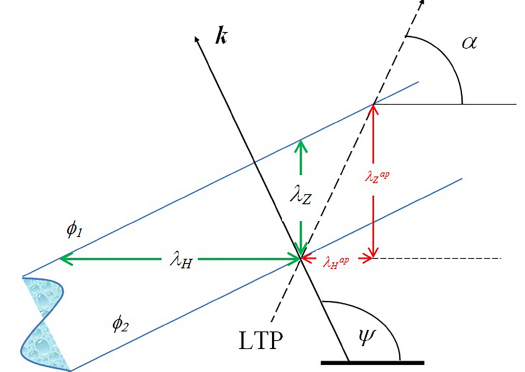
Figure 1. Vertical α -plane defined by the elevation angle between the sounding path direction and its projection on the horizontal plane. Real and apparent, vertical and horizontal wavelengths are indicated. ϕ 1 and ϕ 2 represent two arbitrary successive constant phase surfaces belonging to a monochromatic GW (see text). The expected distortion from real to apparent wavelengths, is